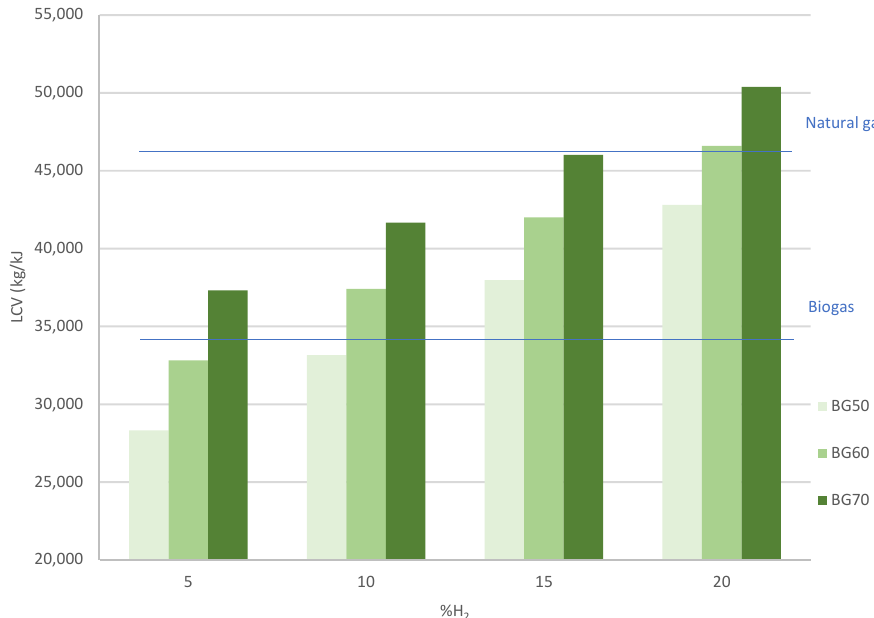
Figure 3. Heating value comparison of BG50, BG60 and BG70, depending on hydrogen content.